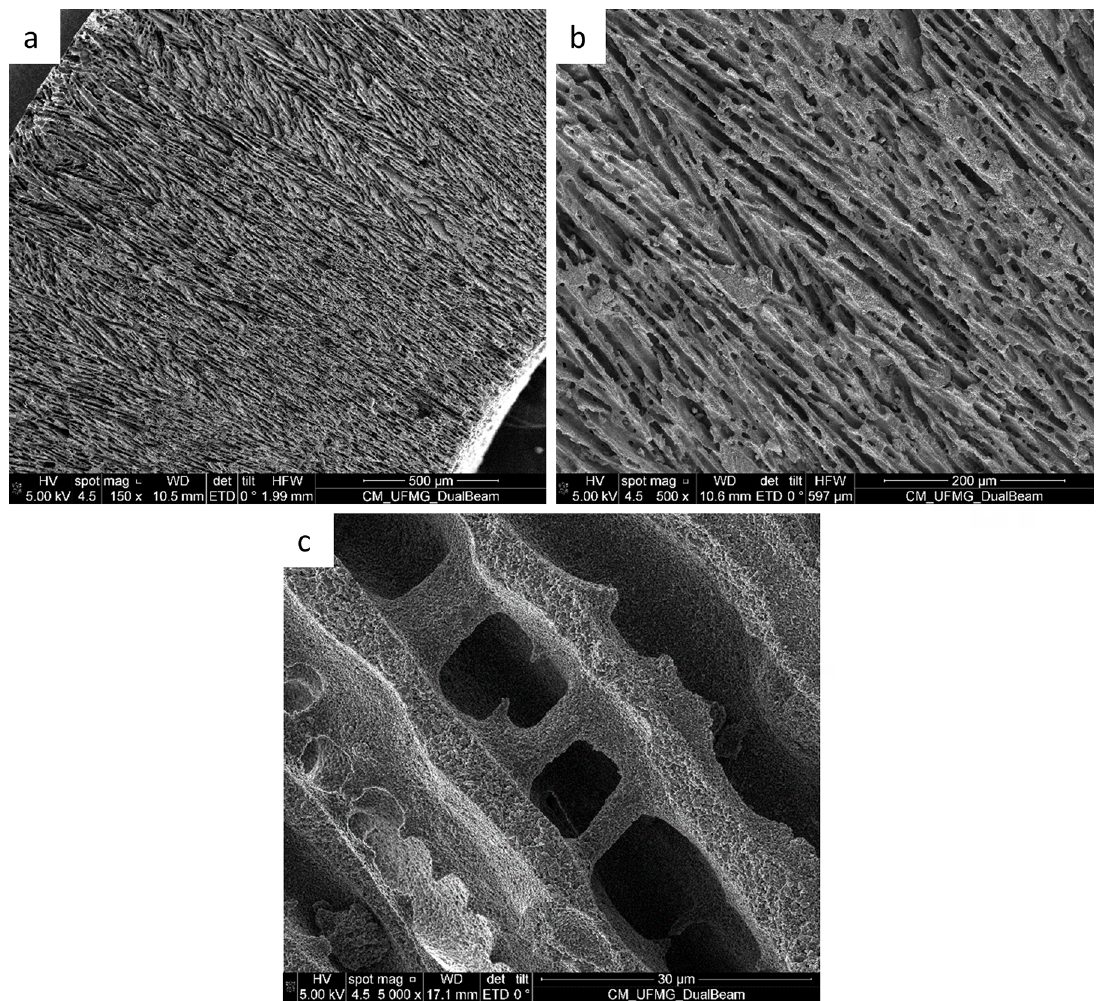
Figure 3. Tubular alumina substrates: (a) and (b) showing radially aligned porosity at different magnifications, and (c) the trans-lamellar ceramic